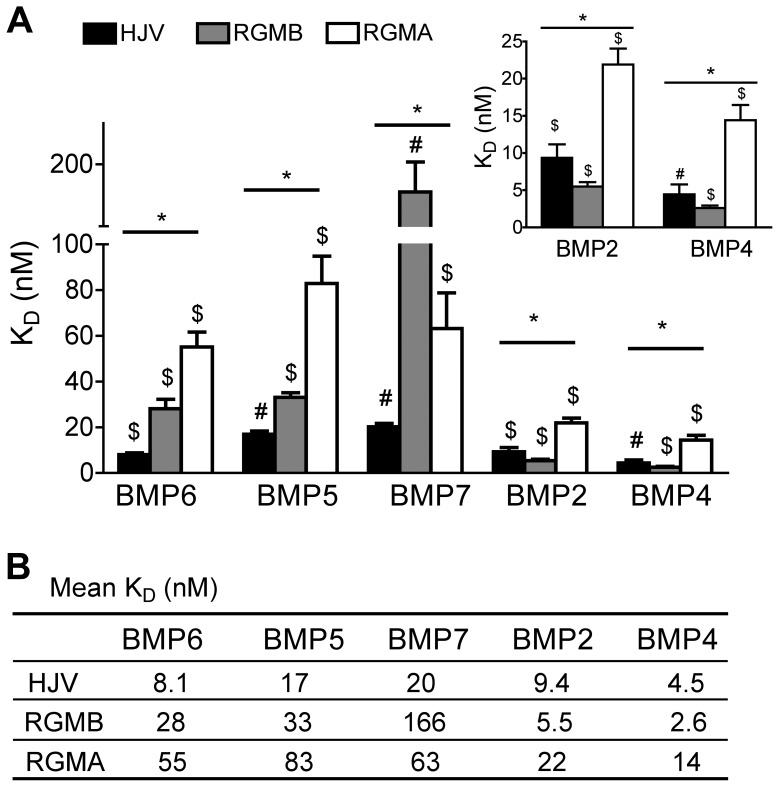
Binding affinity of RGM proteins for BMP ligands.(A) The binding affinity (KD = Koff/Kon) of each RGM protein for each BMP ligand was measured by surface plasmon resonance and plotted as mean ± SD (n = 4–9 per group). The mean KD ± SD of RGM proteins for BMP2 and BMP4 is also shown as an inset to better demonstrate their lower KD values. The mean KD is reported numerically in (B). (A) Black bar: HJV; gray bar: RGMB; white bar: RGMA. Statistical significance among 3 RGM proteins for binding to each BMP ligand was determined by one-way analysis of variance (ANOVA) with the Dunnett’s post-hoc test for pair-wise multiple comparisons (* all comparisons are significant (P<0.05)). For comparisons among 5 BMP ligands for binding to each RGM protein, one-way ANOVA with the Bonferroni’s post-hoc test was used (# all comparisons are significant (P<0.05); $ not all comparisons are significant: for HJV, all pair-wise comparisons between BMP ligands are significant except for BMP2 vs BMP6; for RGMB, all pair-wise comparisons between BMP ligands are significant except for BMP2 vs BMP4 and BMP5 vs BMP6; for RGMA, all pair-wise comparisons between BMP ligands are significant except for BMP2 vs BMP4, BMP5 vs BMP7 and BMP6 vs BMP7.